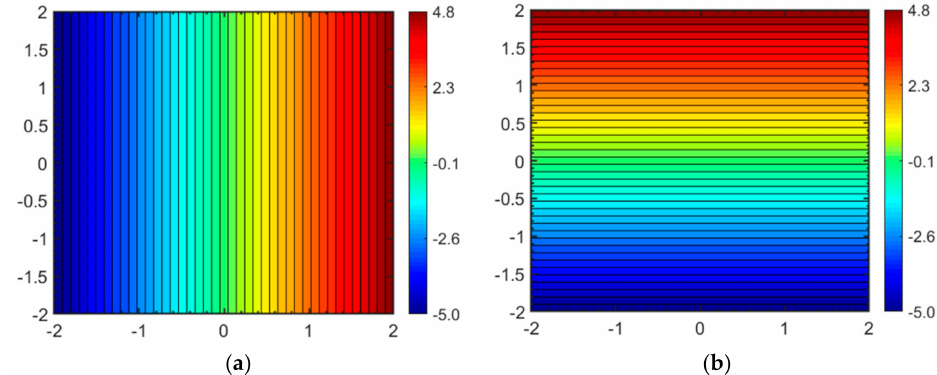
Figure 1. Uniform far-field flow with ( a ) Potential function values ( Φ ) given by rainbow colors (m 2 · s − 1 ) relative to line x = 0. ( b ) Stream function values ( Ψ ) given by rainbow colors (m 2 · s − 1 ) relative to line